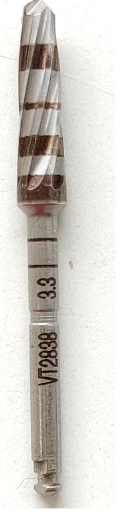
Figure 2. Osseodensification drill VT2838(3.3) (Versah